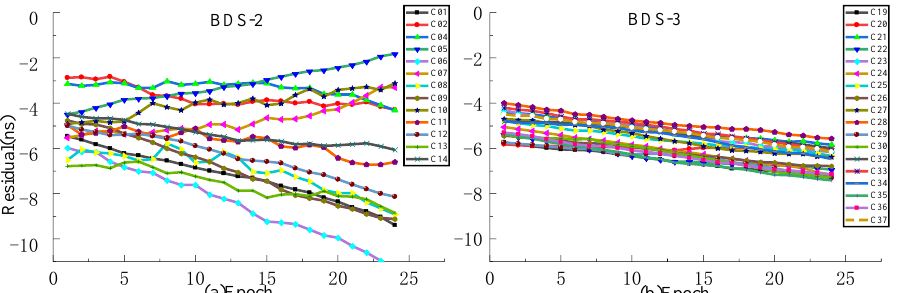
Figure 10. The residual plot of QP model using the initial hour update ultra-fast clock product of the next day. ( a ) The residual value of BDS-2 predicted after 6 h. ( b ) The residual value of BDS-3 predicted after 6 h.